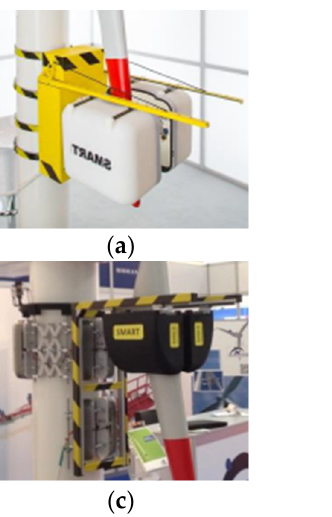
Figure 3. Design studies scaled by 1:20: ( a ) belt climbing ring robot; ( b ) Lego based design; ( c ) crawlers with scissors; ( d ) final concept .